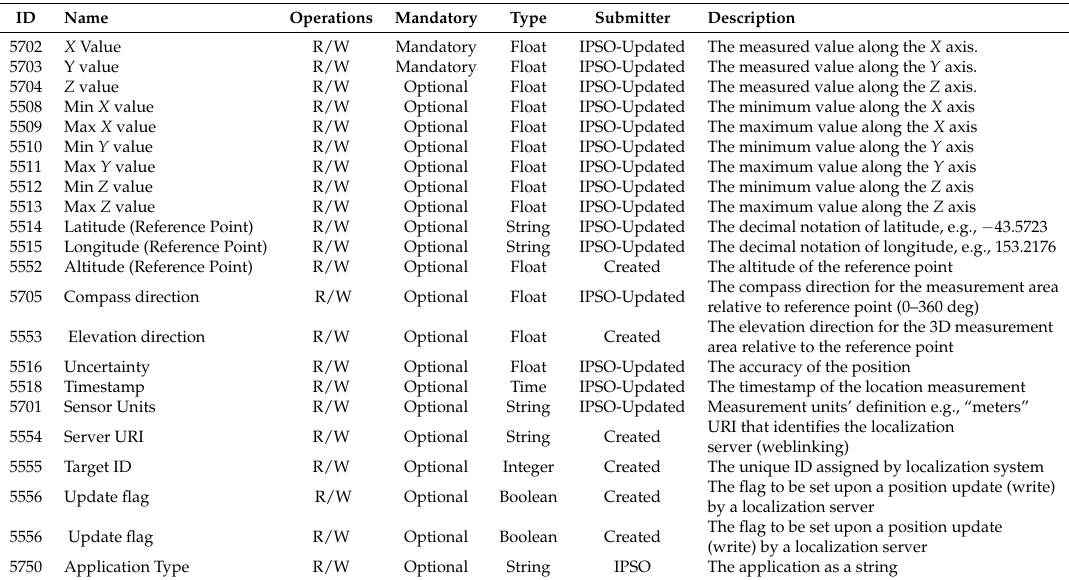
Table 3. Position object based on LwM2M/IPSO (Object ID 3360).